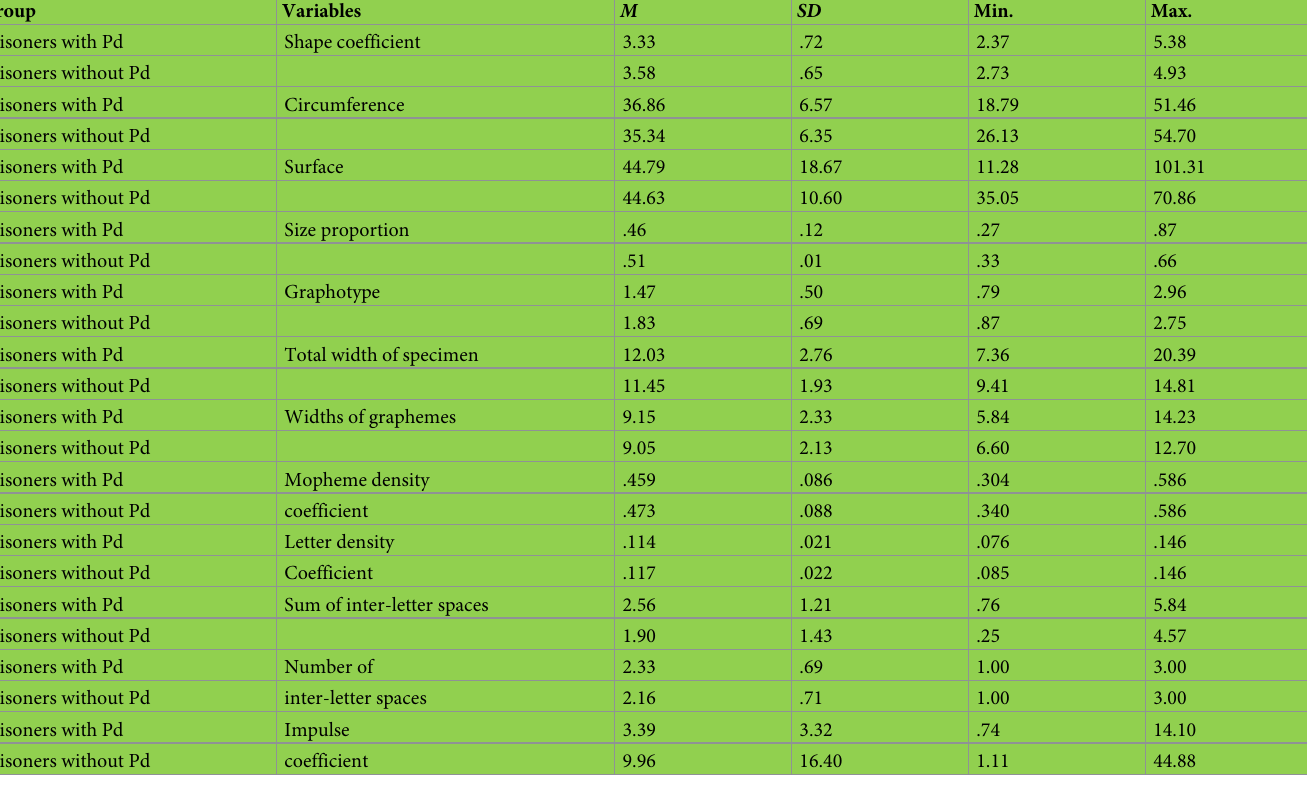
Table 2. Descriptive statistics for the graphical variables identified on GlobalGraf